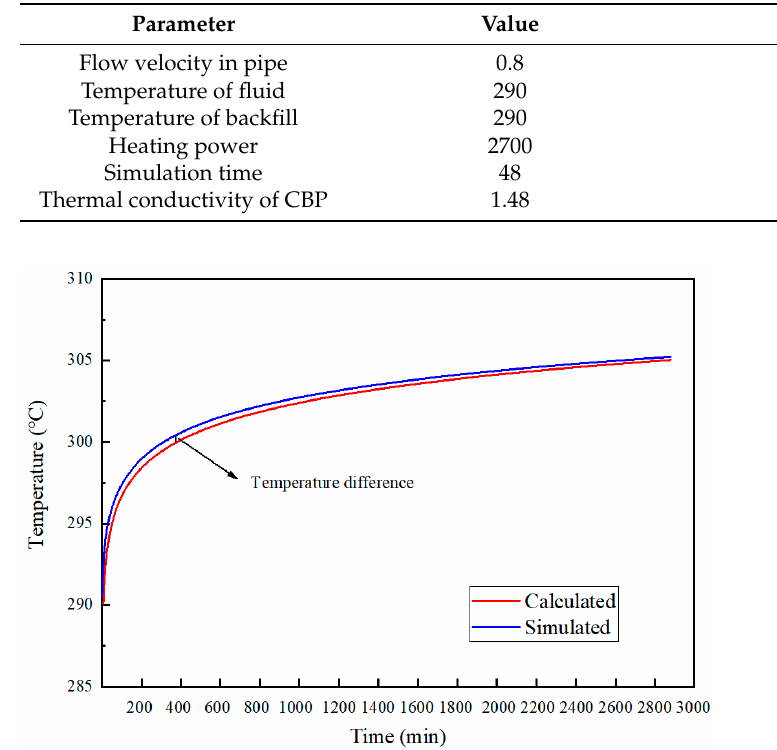
Figure 6. The analytical and simulated variation of average fluid temperature over time.